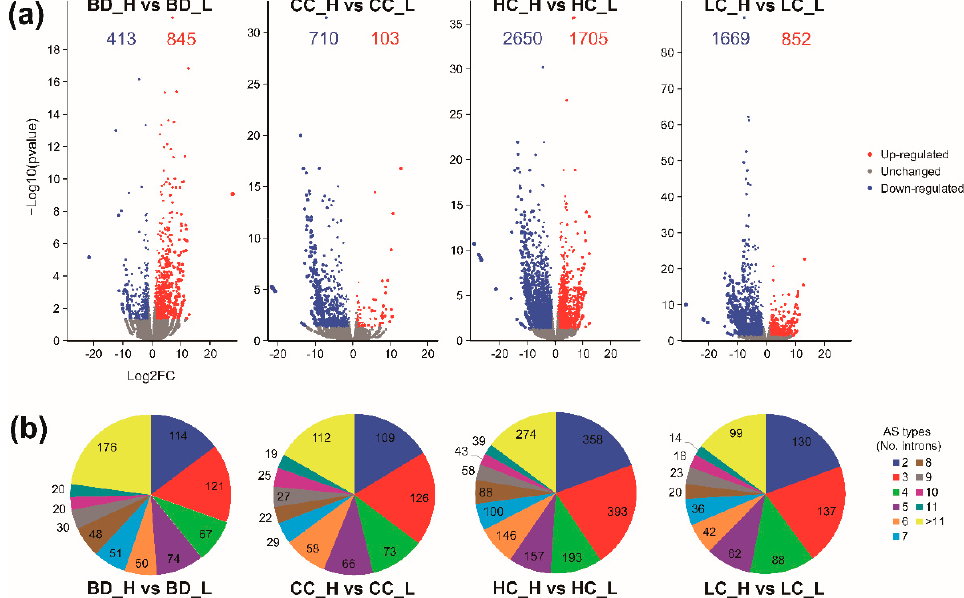
Figure 2. Identification of DEGs ( a ) and significant AS events ( b ) in groups of different traits. AS types represent the number of introns included in the AS events ranging from two to >11 introns, and the values in the circle represent the number of AS events.